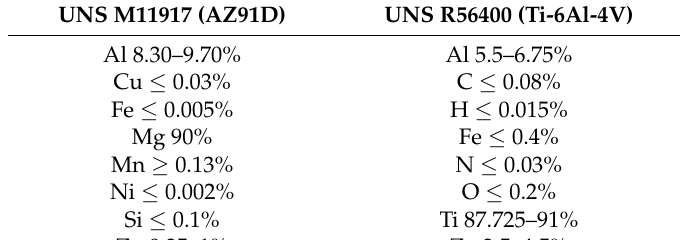
Table 3. Chemical compositions of materials used for manufacturing specimens.